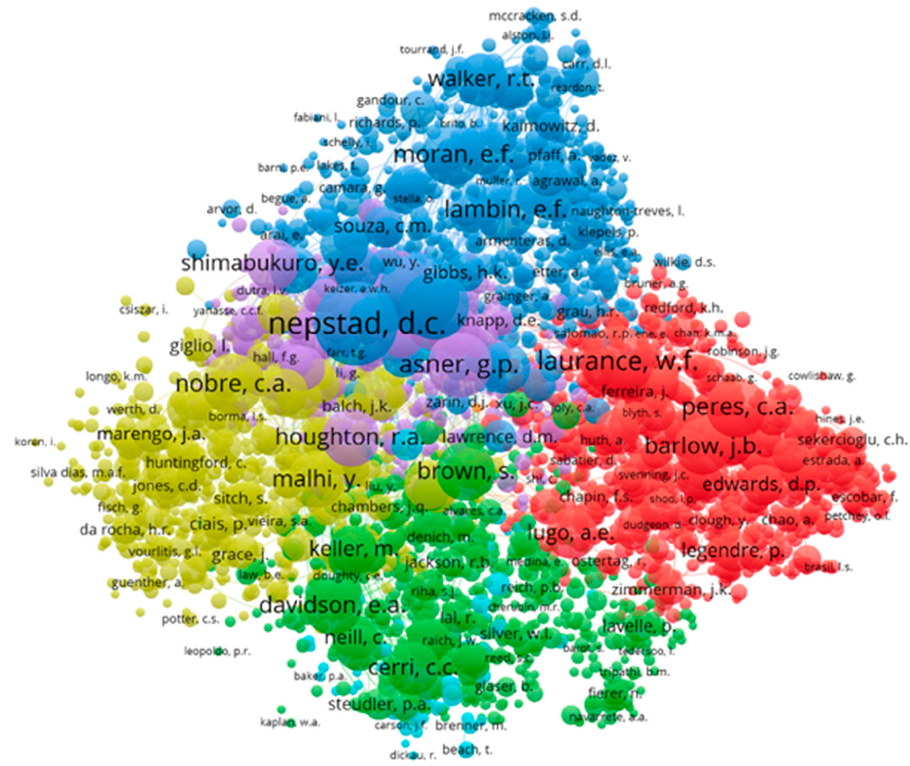
Figure 5. Network and grouping of co-cited authors. Clusters of the same color represent authors with collective knowledge.